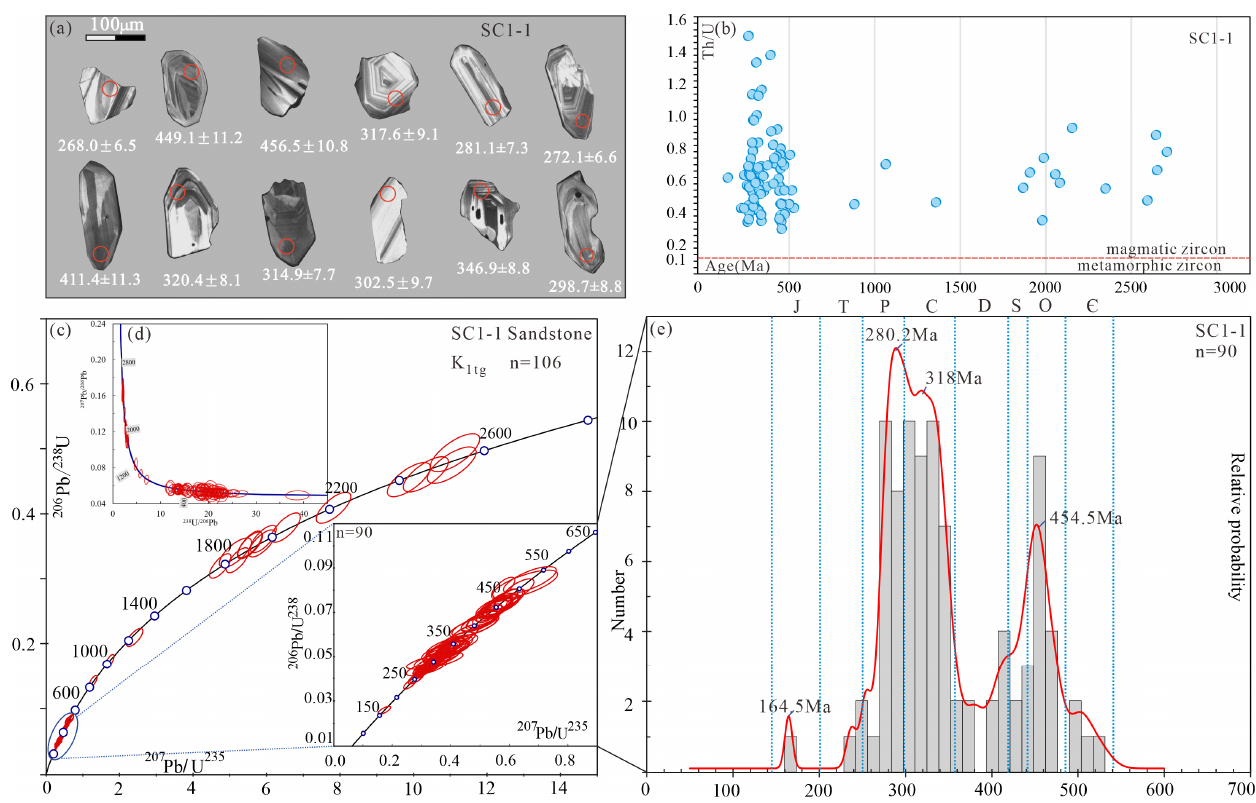
Figure 4. ( a ) Representative cathodoluminescence images of analyzed grains, ( b ) plots of Th/U ratios versus U-Pb ages of concordant detrital zircons, ( c ) zircon U–Pb concordia plots, ( d ) inverse concordia diagrams (Tera–Wasserburg), and ( e ) detrital-zircon kernel density estimate (KDE) diagrams.